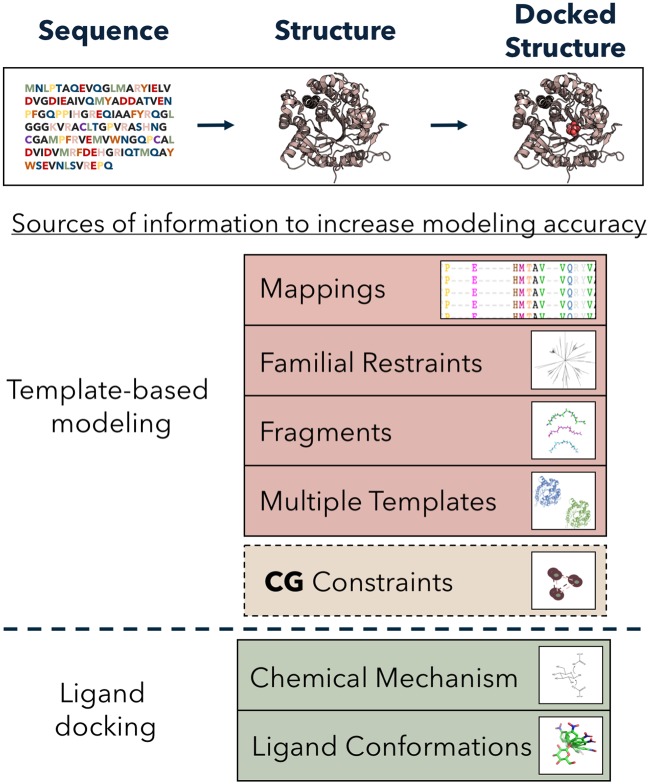
Addition of information to augment template-based modeling and ligand docking protocols.Sequence → Structure Beginning with a target sequence, apo protein structures can be predicted. The accuracy of these models has been shown to increase with the addition of other sources of information, including accurate sequence-structure mappings (alignments) [13], familial (evolutionary) constraints [14], multiple templates [15] and fragments [16] Structure → Docked Structure Taking the apo structure and docking a ligand into results in a docked structure, with a ligand bound. The accuracy of these models has been shown to increase with the addition of ligand conformational degrees of freedom and chemical mechanism constraints. By adding CG constraints, we measure the increase in accuracy over the entire pipeline.